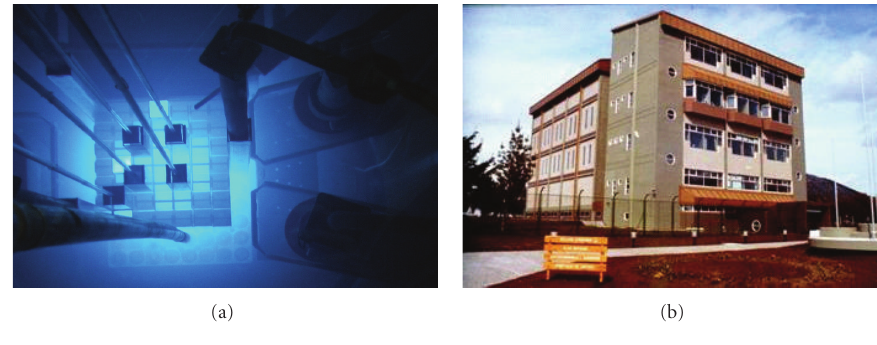
Figure 1: RA-8 criticality assembly.